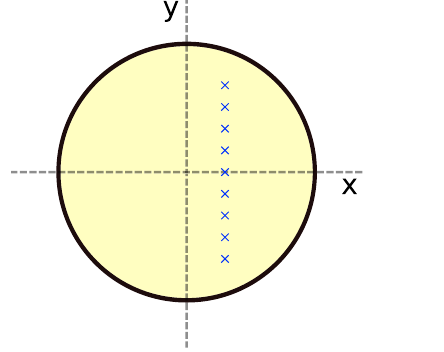
FIG. 2. A cross section of the aperture of the ACS and the beam is scanned vertically with a horizontal offset with blue x ’ s showing the scan positions.